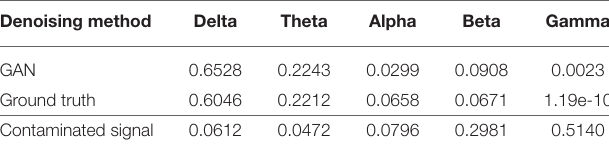
TABLE 4 | Power ratios of different frequency bands before and after 50 Hz noise